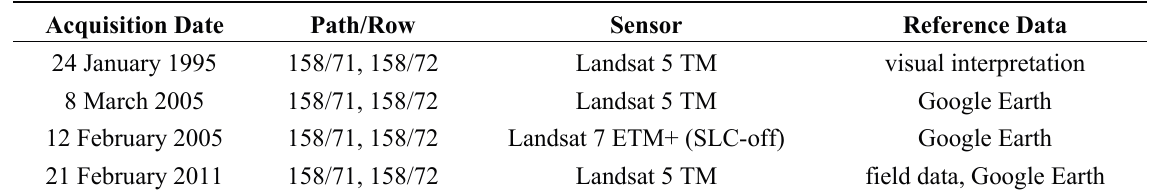
Table 1. Acquisition dates, sensor, and coverage of the used satellite